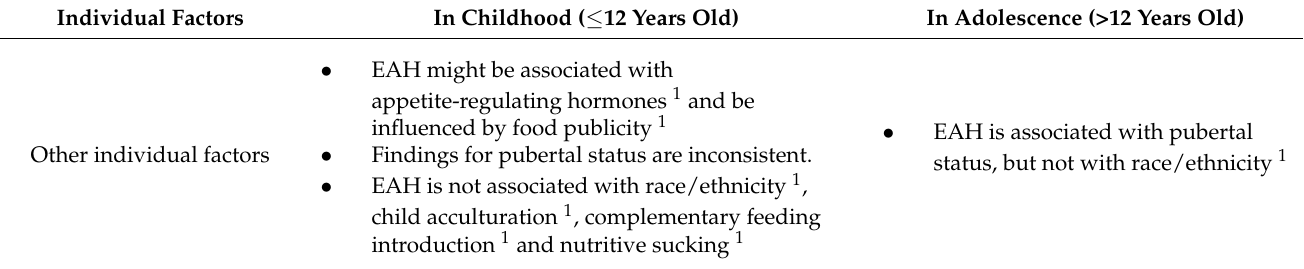
Table 2. The overall conclusions for familial factors associated with eating in the absence of hunger (EAH) in children and